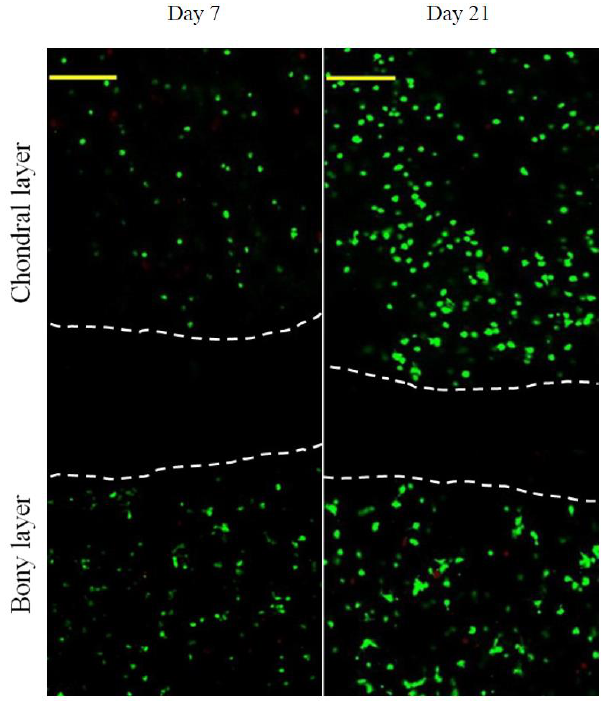
Figure 5. Confocal microimages for live/dead-staining of cells (vertical sections of the layered scaffold seeded with chondrocytes in chondral layer and osteoblasts in bony layer). Images show z-projection of a 100 μ m z-stack (green, viable cells; red, dead cells; scale bar, 250 μ m; areas between white dashed lines indicate the cell-free zones and correspond to the mimetic calcified layer).